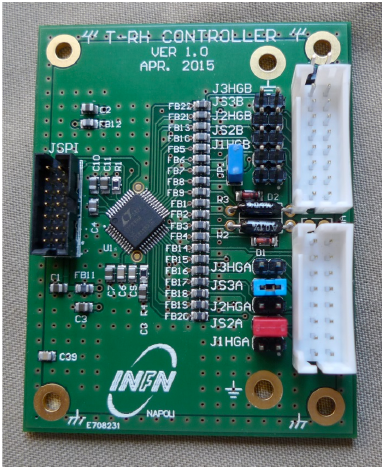
Figure 2. The T-Rh controller based on LTC2983 System-On-Chip.